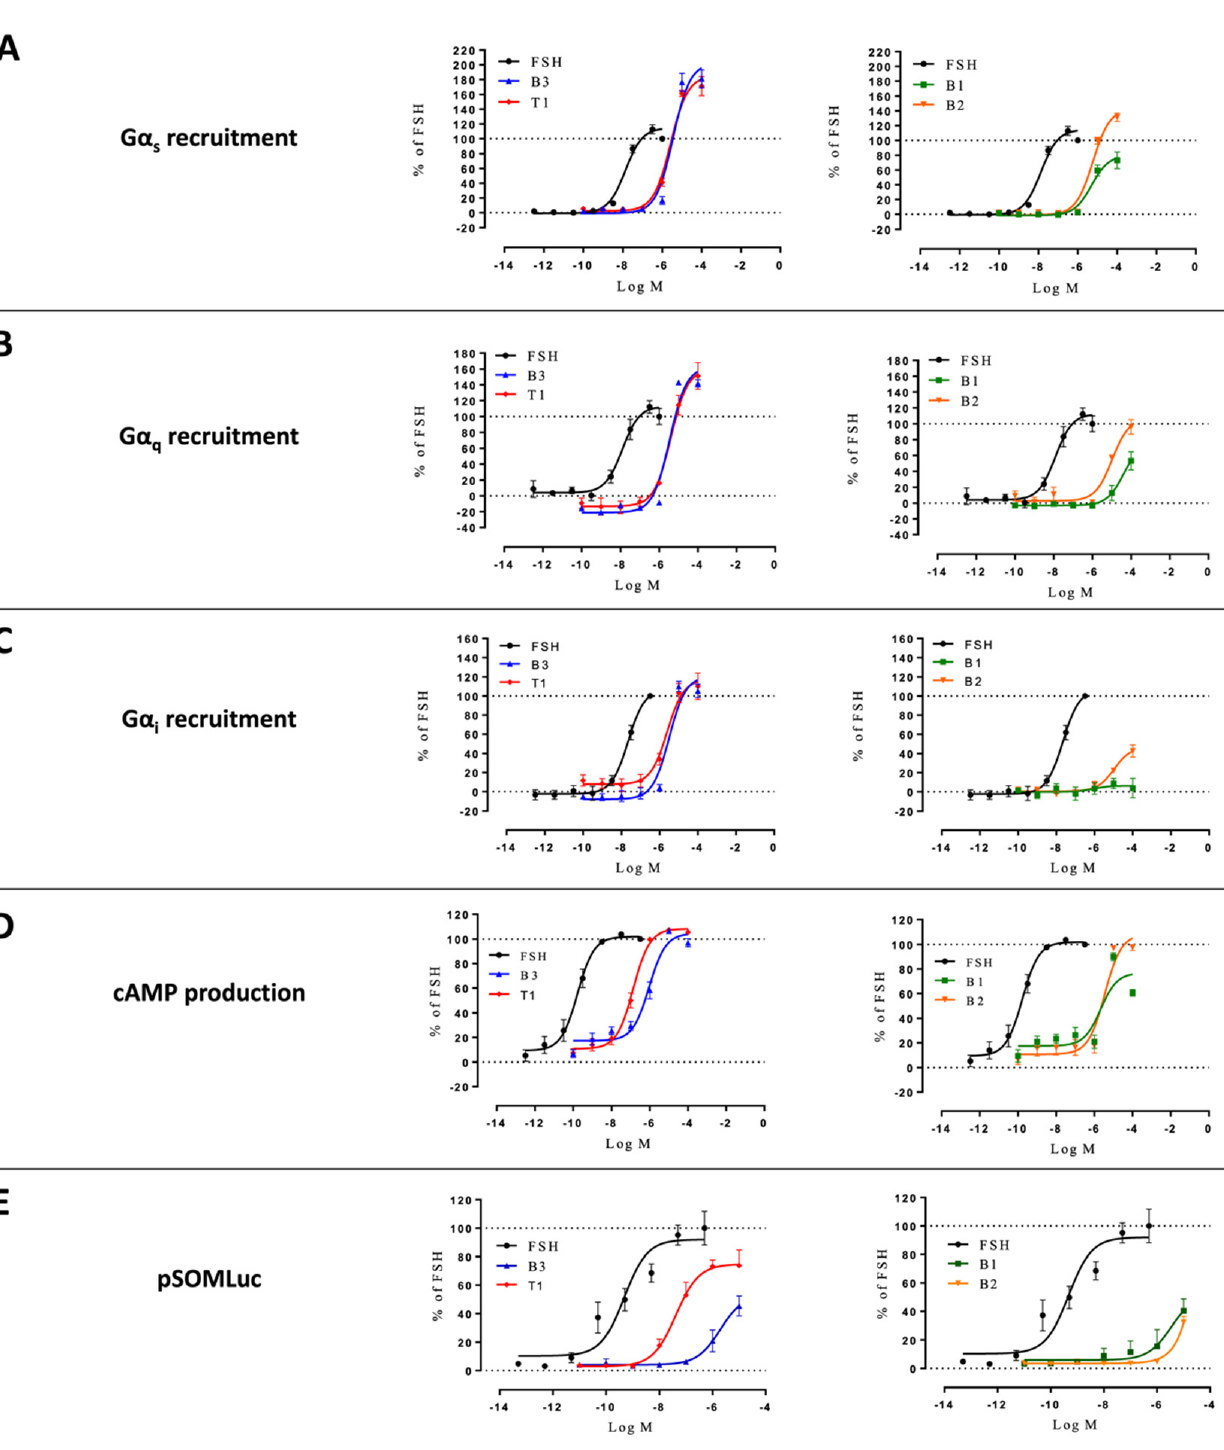
Figure 7. Profiling of LMW ligands vs. FSH in HEK293/ ∆ ARRB cells. ( A ) G α s recruitment, ( B ) G α q recruitment, ( C ) G α i recruitment, ( D ) cAMP production, and ( E ) CRE reporter gene induction were measured. Transfected HEK293/ ∆ ARRB cells were challenged with increasing doses of FSH (10 − 12.5 to 10 − 6.5 M) or LMW ligands (10 − 10 to 10 − 4 M). Signals were monitored for 30 min. Concentration/activity curves were calculated by considering the area under the curves. Values were normalized considering FSH maximal response as 100%, plotted, and fitted using non-linear regression. Data are represented as mean ± SEM from at least six independent